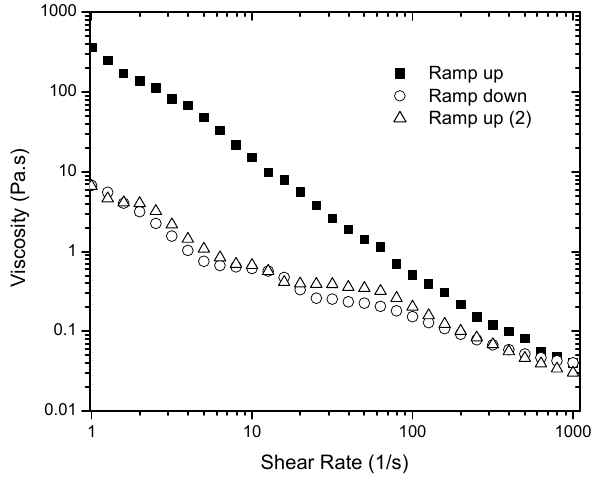
Figure 2. Viscosity measurements of 6% gel. Three runs were carried out using the same sample: shear rate was increased from 1 to 1000 s − 1 (ramp up), varied from 1000 to 1 s − 1 (ramp down), and increased from 1 to 1000 s − 1 (ramp up 2).